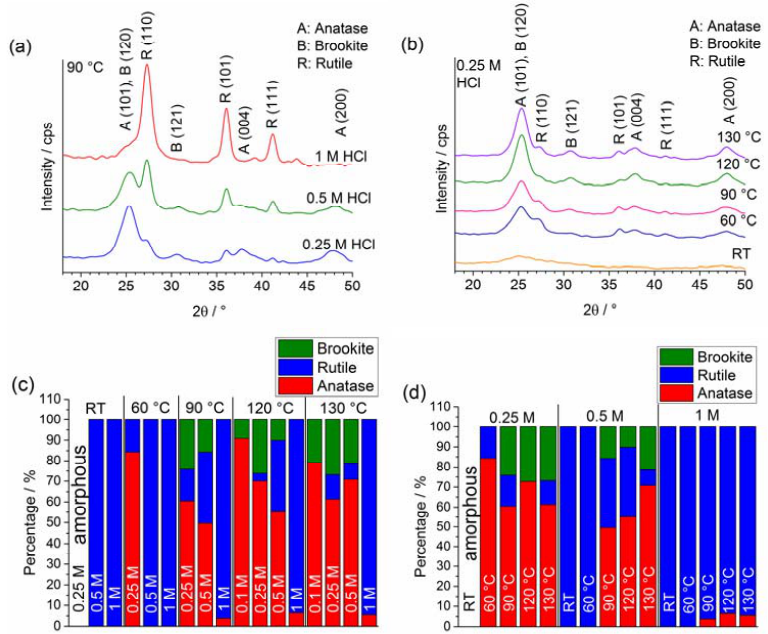
Figure 1. XRD (X-ray diffraction) pattern (( a , b ) smoothened with a 17 point FFT (fast Fourier transform) filter) and the percentage of phase type ( c , d ) of TiO 2 powder prepared at different temperatures and with different acid concentrations. In ( a ) the acid concentration was increased and the temperature stayed constant at 90 ◦ C. In ( b ) the temperature was changed and the acid concentration was kept at 0.25